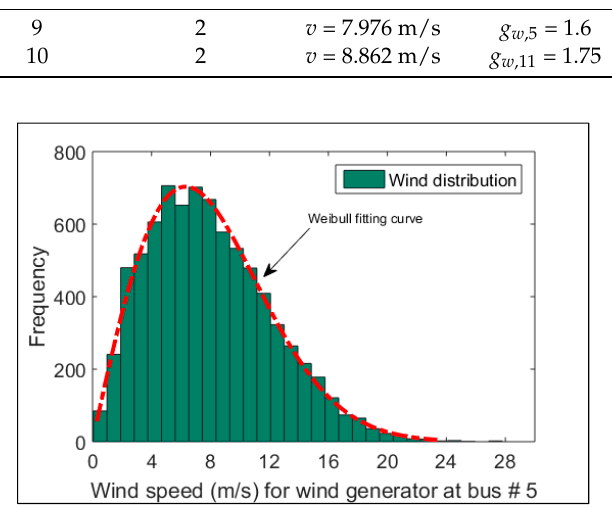
Appl. Sci. 2021 , 11 , x FOR PEER REVIEW Figure 2. Wind speed distribution at bus #5. Figure 2. Wind speed distribution at bus #5.